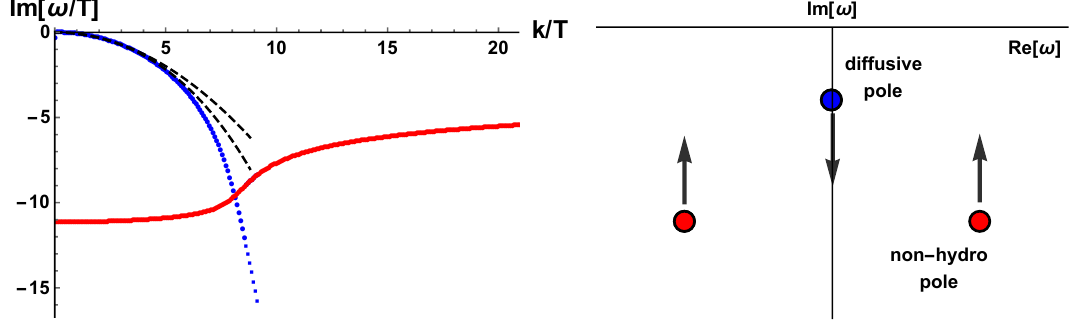
Figure 8 . The QNMs spectrum in the shear channel for m 2 = 0. Left: the dashed black lines are the analytic expression for the di(cid:11)usion mode at O ( k 2 ) ; O ( k 4 ) from [53]. The blue mode is the hydrodynamic di(cid:11)usive one and the red one is the (cid:12)rst non-hydro pole. Despite the crossing of the modes in the Imaginary axes there is no real modes collision in the complex plane and no k -gap is formed. Right: a cartoon of the poles crossover increasing k=T . This situation does not produce a k -gap but just a simple di(cid:11)usion to sound